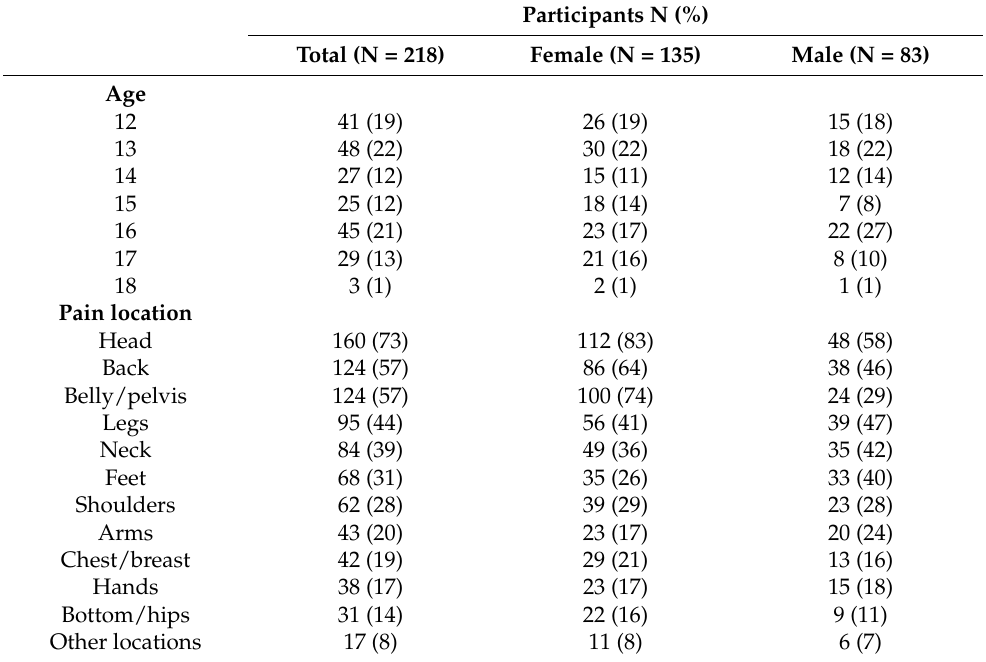
Table 1. Descriptive data for the study sample (N =